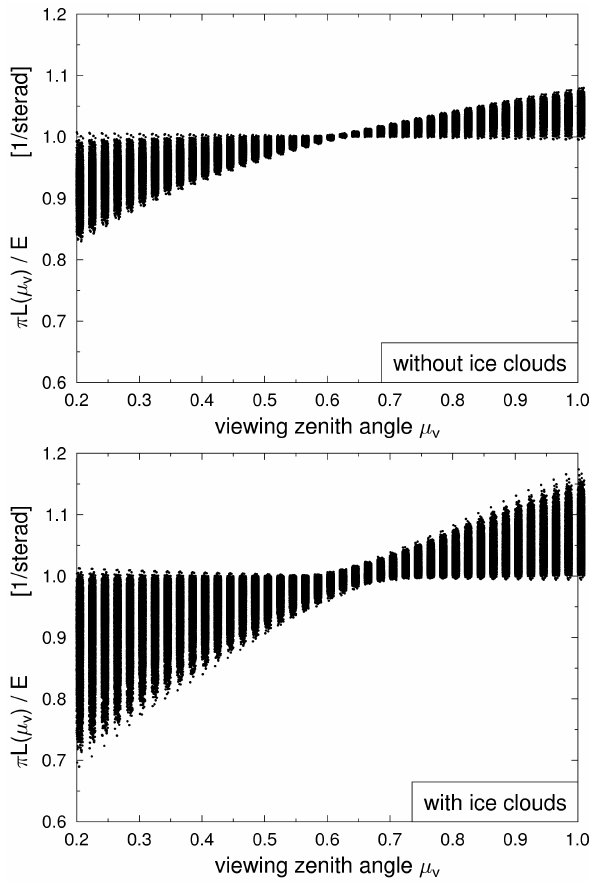
Fig. 4. The ADM (see Eq. 4) as a function of the cosine of the viewing zenith angle µ v = cos θ v for cases without (top) and with (bottom) cirrus.